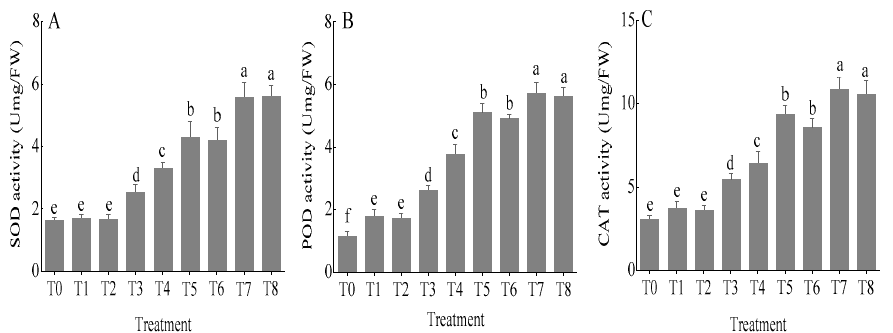
Figure 9. Effects of TL6 and TL13 treatments on ( A ) SOD, ( B ) POD, and ( C ) CAT activities in the leaves of snow pea plants under F. solani and F. avenaceum stress at 21 days after pretreatment. Data are presented as mean ± standard errors (SE) of two independent experiments in three replicates. Means with the same lowercase letters are not significantly different at p < 0.05, according to Duncan’s multiple range tests.